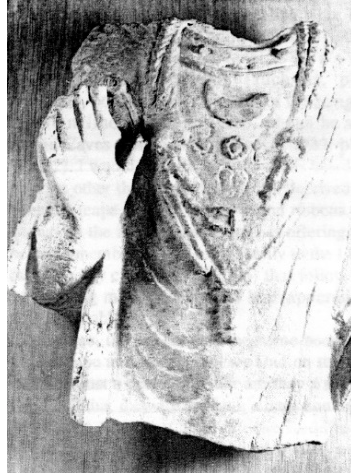
Figure 3. Buddha figure wearing a cape and jewels. Ha ḍḍ a. Stucco fragment. Musée Guimet, Paris (MG 20996). Photograph from Taddei (1989), courtesy of the Musée Guimet.